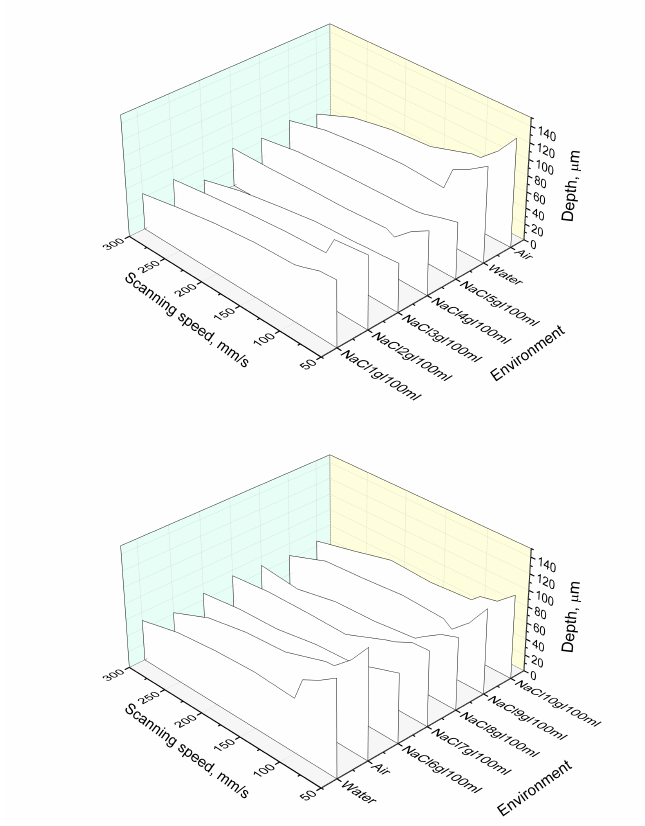
Figure 3. Depth of the grooves formed in the glass sample in dependence on the scanning speed. Grooves were formed while the glass sample surface was dry and immersed in different concentrations (from 1 g /100 mL—to—10 g/100 mL) of NaCl aqueous solutions, and water. Number of scans—15, average power—5 W, pulse repetition rate—60